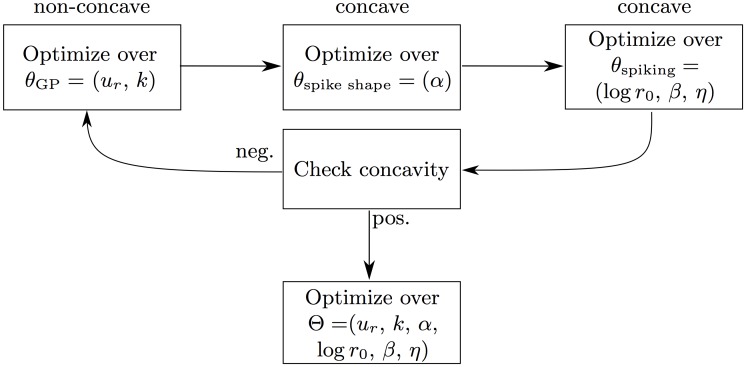
This schematic shows the optimization scheme that is used to learn the parameters of the AGAPE model when it is fitted to the data (for a given δ).As long as the current parameter estimate sits in a non-concave region of the likelihood function, the top cycle optimizes over different subspaces of the parameter space. If and when a concave point is reached, the optimization proceeds in the full parameter space. This whole scheme is repeated for each value of δ in order to find the optimal one.